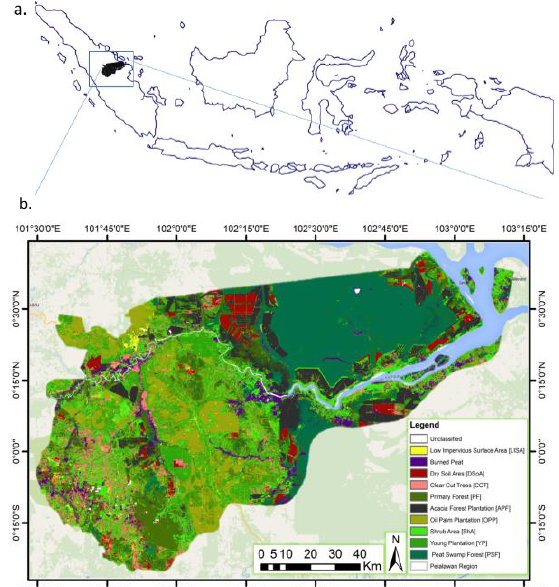
Figure 1. (a). The study area of Pelalawan District, Riau Province, Indonesia, (b). Supervised classification result in Pelalawan region.